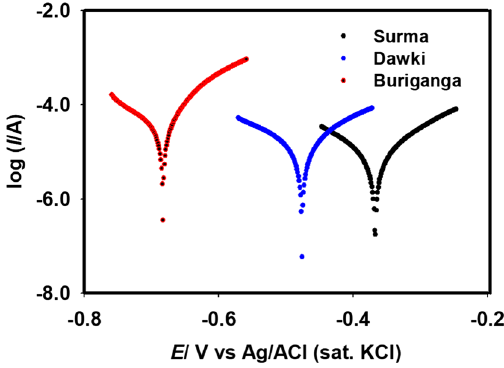
Fig. 3 The Tafel plots of Fe electrode recorded for different river waters under room